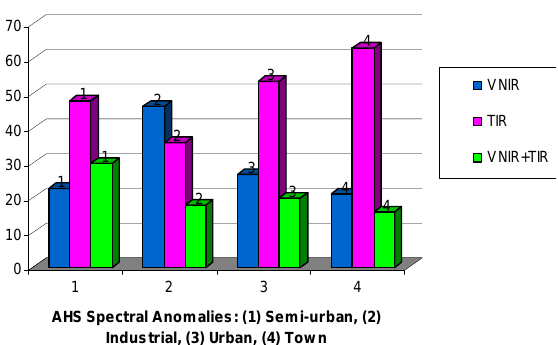
Figure 7. Comparison of AHS anomalies between Semi-urban areas (1, orange area), Industrial (2, cyan area), Urban/Residence (3, yellow area) and Town (4, red area) in the Alcalá de Henares test site. Validation for Alcalá de Henares test site (white rectangle is the AHS image cover). VNIR anomalies (blue), TIR (magenta) and both VNIR-TIR (green). (Source: Google Earth).